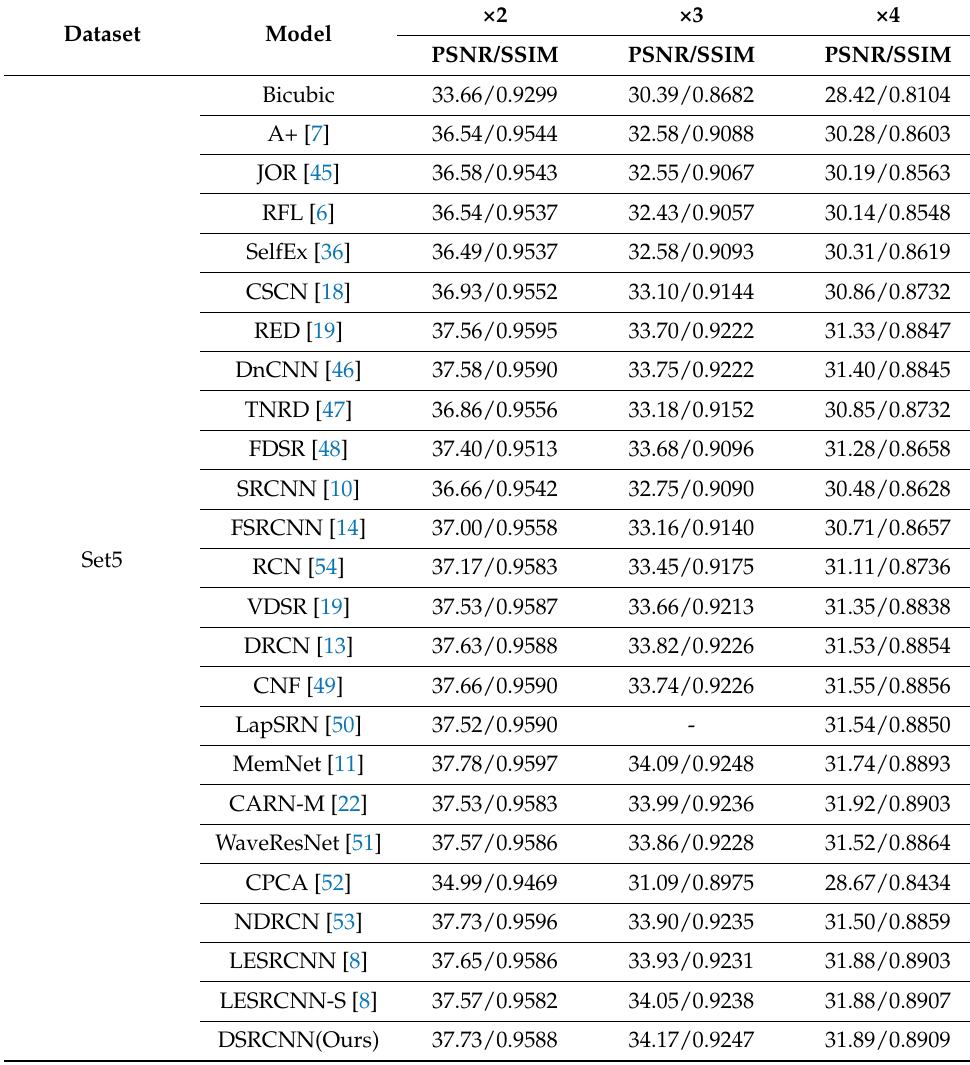
Table 2. PSNR and SSIM of different techniques with scale factors of ×2, ×3 and ×4 on Set5. Dataset